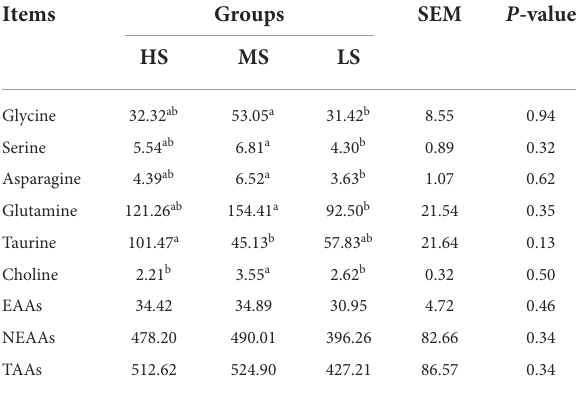
TABLE 4 Effect of different energy level diets on the volatile flavor compounds in the longissimus lumborum of Tibetan sheep (% of total volatile flavor compounds).